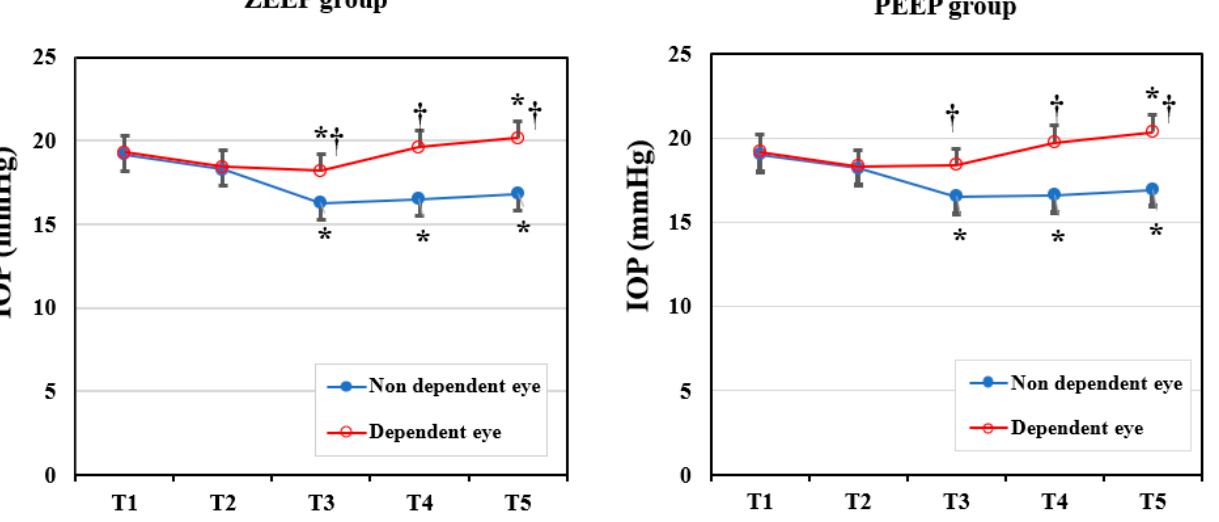
one-lung ventilation; T4: 60 min after position change to lateral decubitus and one-lung ventilation; T5: 10 min after two-lung ventilation in lateral decubitus.